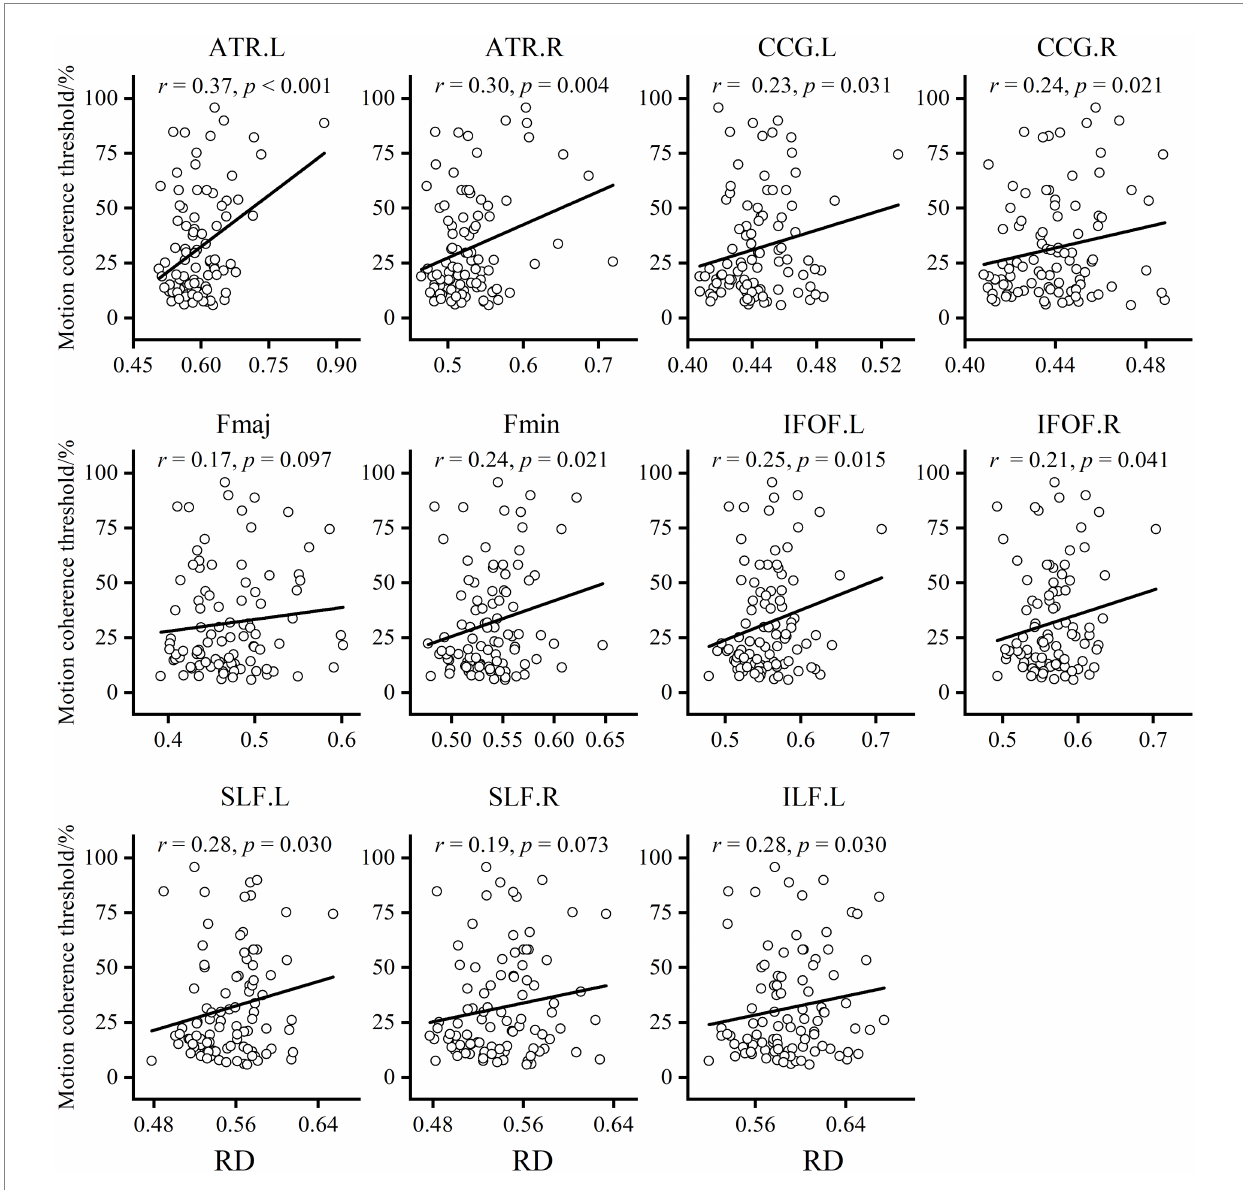
FIGURE 4 Results of the partial correlation analysis between RD and MCT in older adults. Except for Fmaj and right SLF, mean RD in most tracts showed a positive correlation with MCT of the older